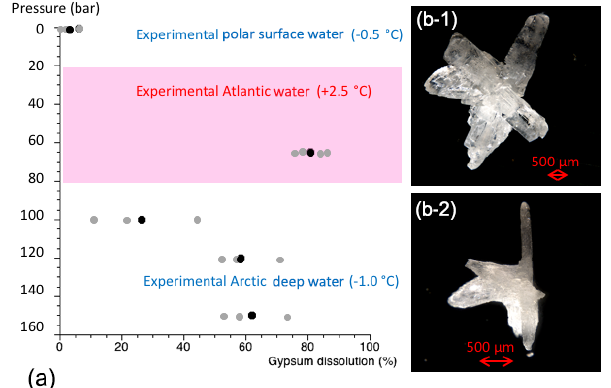
Figure 6. Results from cryogenic gypsum dissolution experiments. (a) Graph showing the position of the simulated Arctic water masses in respect to pressure and temperature and how much gypsum (%) was dissolved on average over a 24h exposure to such pressure and temperature conditions. Grey dots indicate the values from each aquarium and black dots the mean per experiment. (b-1) Cryogenic gypsum crystal of the 120bar experiment before exposure. (b-2) The same cryogenic gypsum crystal of the 120 bar experiment after 24h.